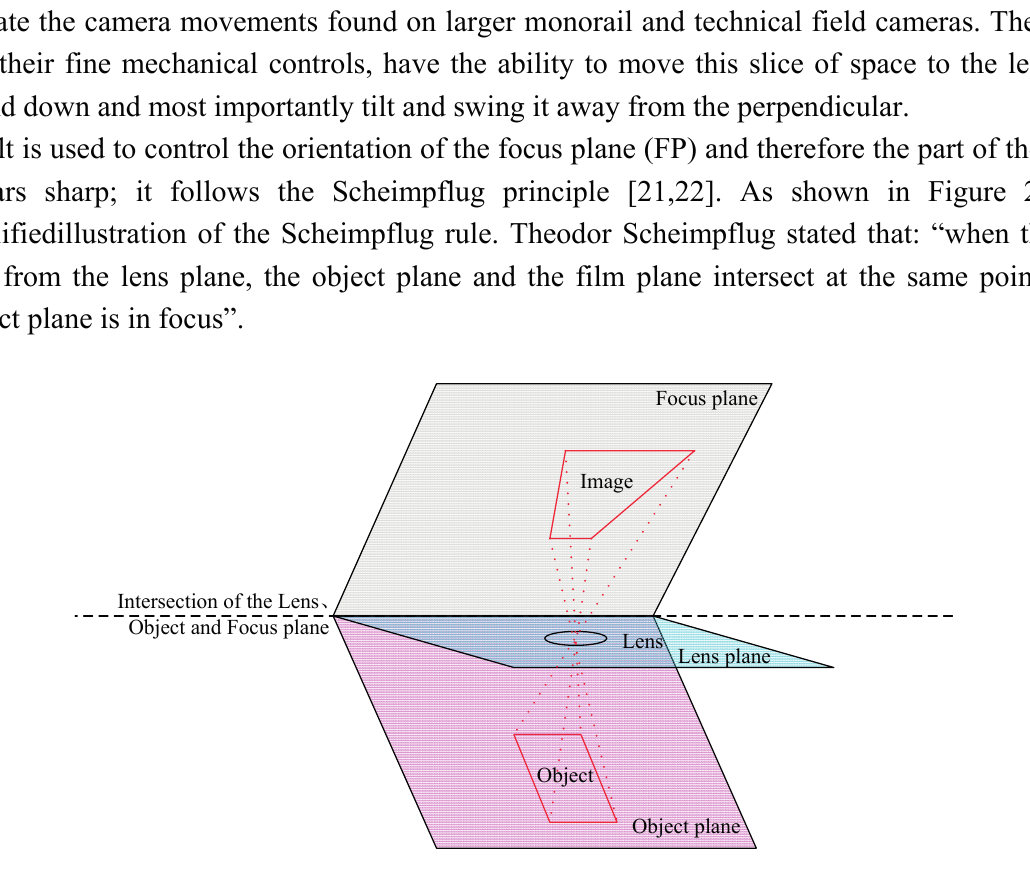
Figure 2. A simplified diagram of the Scheimpflug